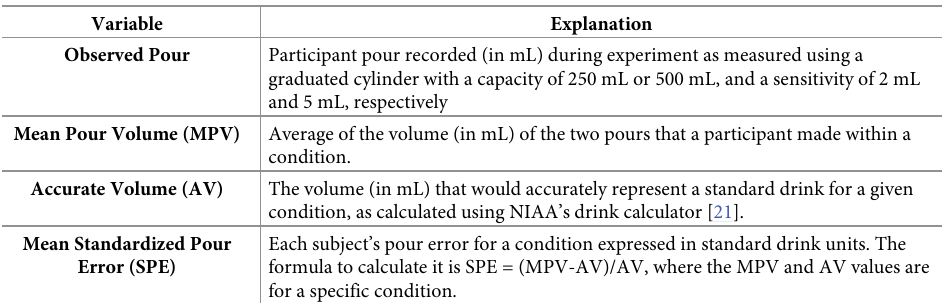
Table 3. Summary of